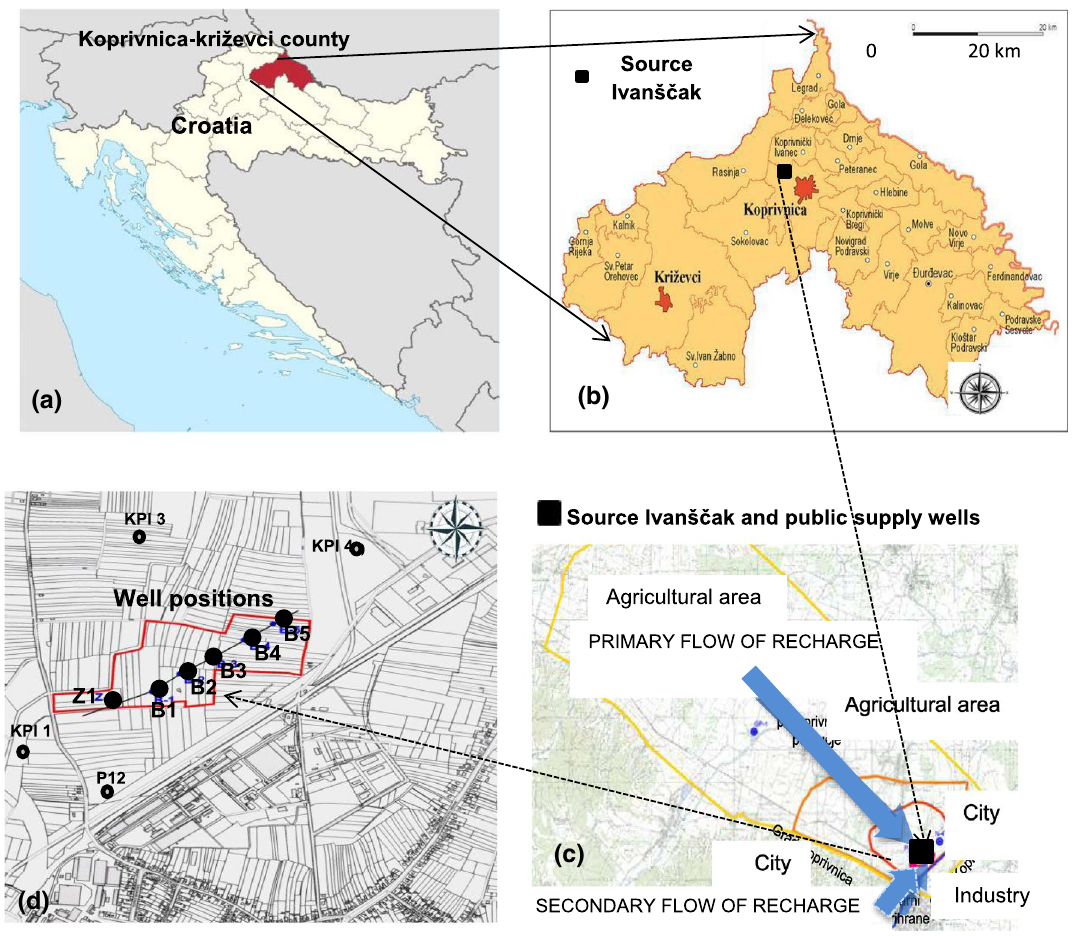
Fig. 1 Study area—Koprivnica city and source Ivanščak location with public supply well positions. Sanitary protection zones: 1. zone (red line); 2. zone (orange line); 3. zone (yellow line). Piezometer locations: KPI 1, KPI 3, KPI 4, P